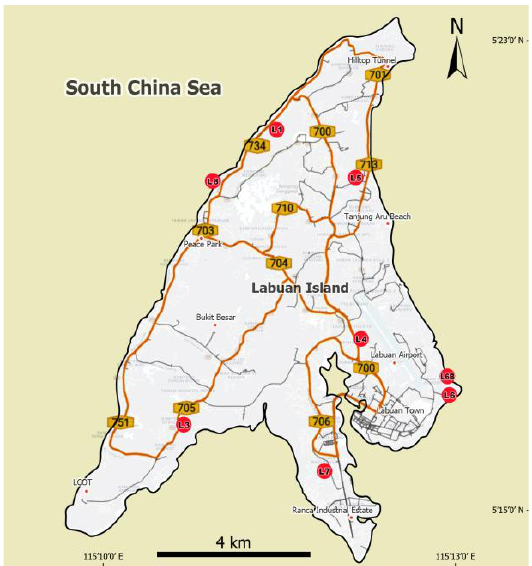
Figure 7. The locations of the studied exposed outcrops on Labuan Island (red dots).